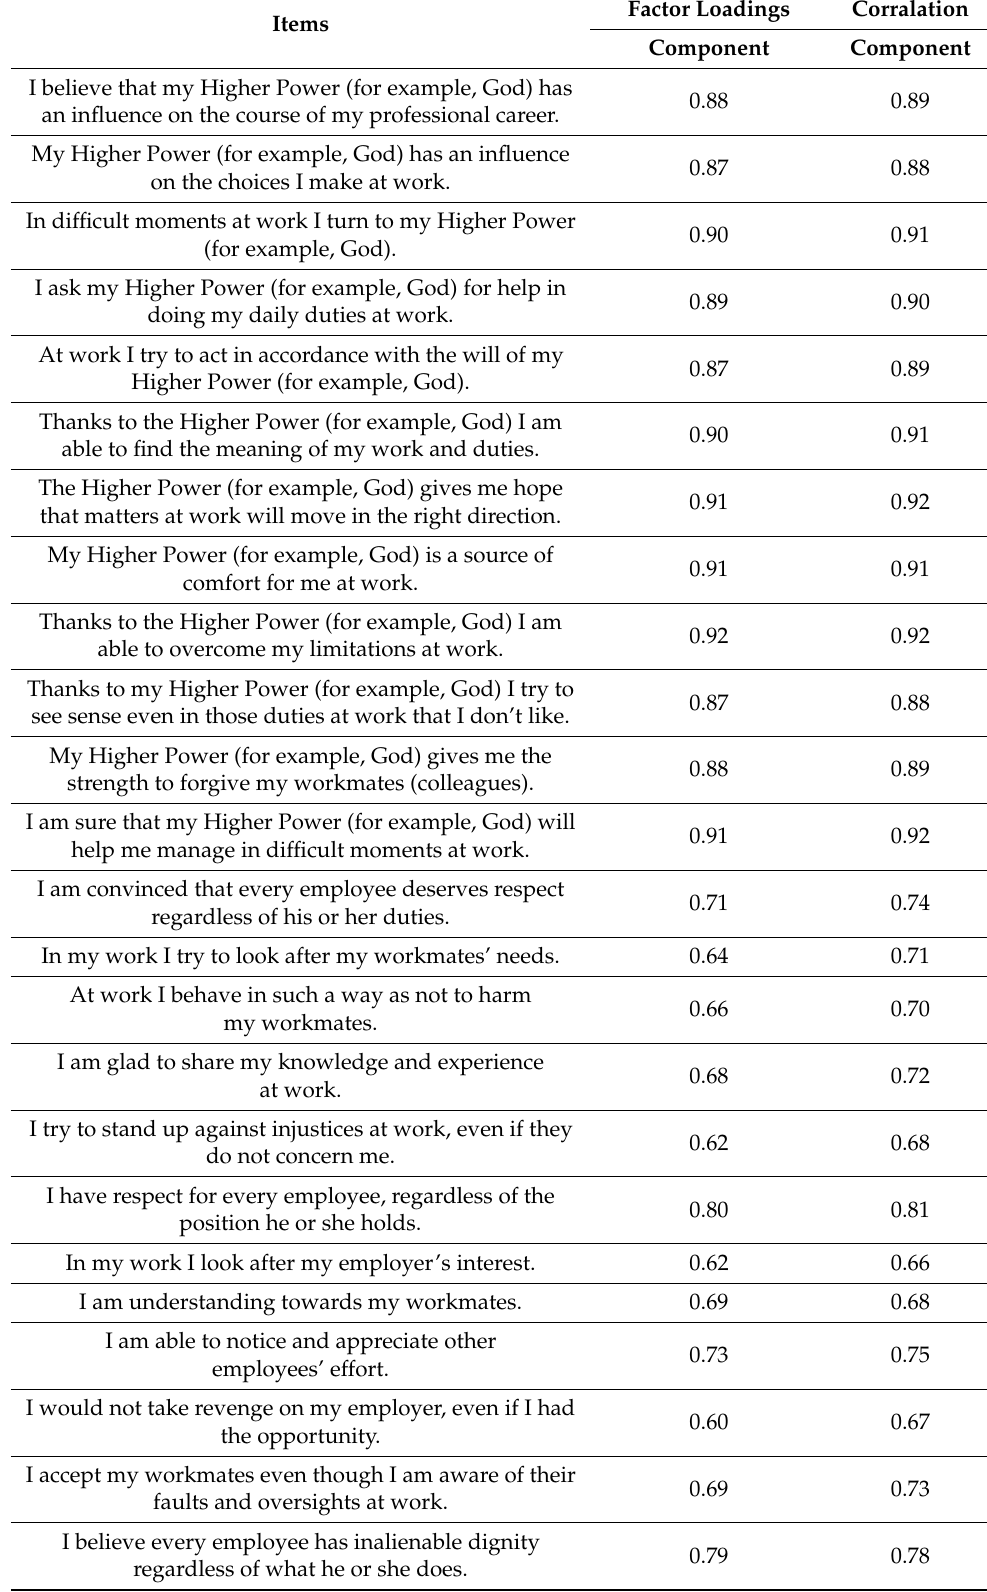
Table 1. Factor loadings and correlation coefficients between factors and items of the employee spirituality scale ( N = 460). Items